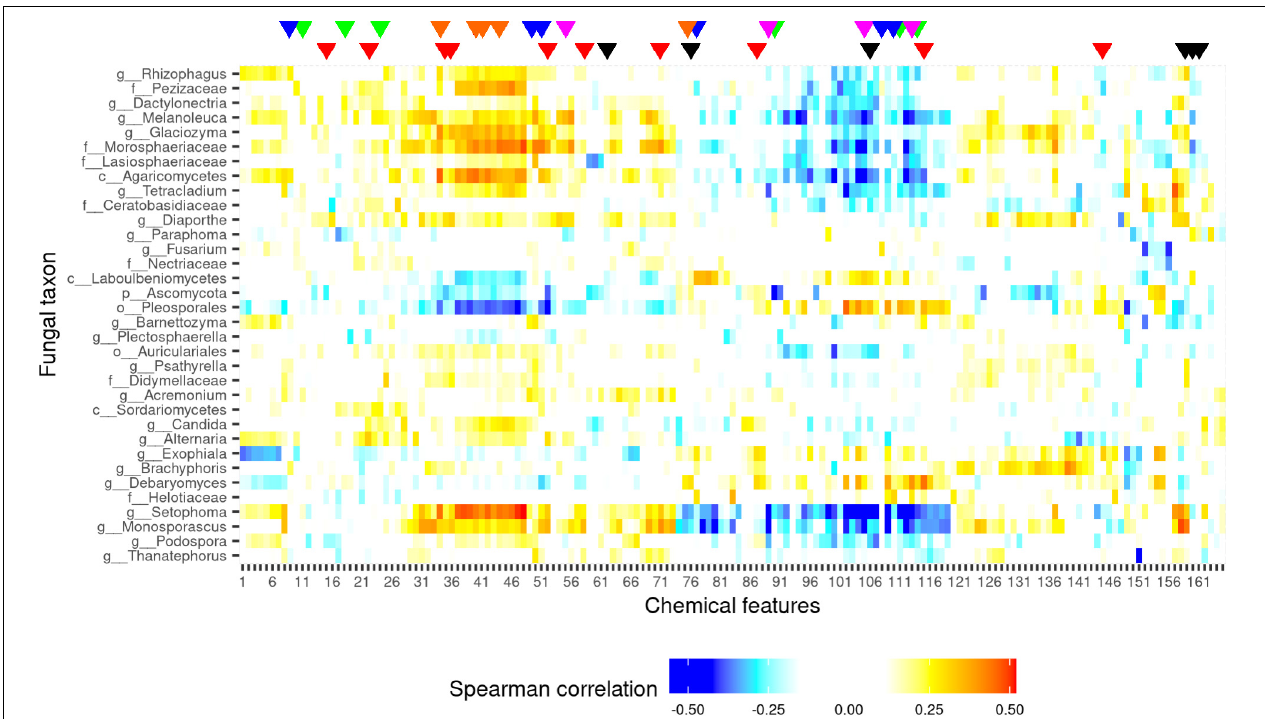
FIGURE 4 | Heatmap of Spearman correlation values between logratio-transformed fungal abundance data (proportion) and core chemical feature abundance data. Both fungi and metabolic features are sorted by hierarchical clustering. Color is proportional to Spearman correlation values. Fungal taxa prefixes follow UNITE notation (“p__,” phylum; “o__,” order; “c__,” class; “f__,” family; and “g__,” genus). Chemical features marked with an arrow include: amino acid derivatives (red): 15, 22, 35, 36, 52, 58, 71, 87, 115, 145; indole derivatives (green): 11, 18, 24, 90, 111, 114; lipids (black): 62, 76, 106, 159-161; peptides (magenta): 105, 113, 89, 55; GSLs (blue): 9, 49, 51, 77, 108, 110; and flavonoid glycosides (orange): 34, 40, 41, 44, 75. For a complete list, see Supplementary Table 9 . The Benjamini–Hochberg adjusted p -values of each correlation can be found on Supplementary Figure 5